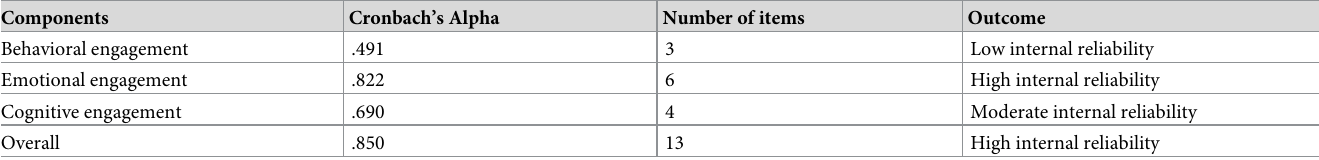
Table 6. Reliability statistics of the finalized version of SEC-RU ( n =